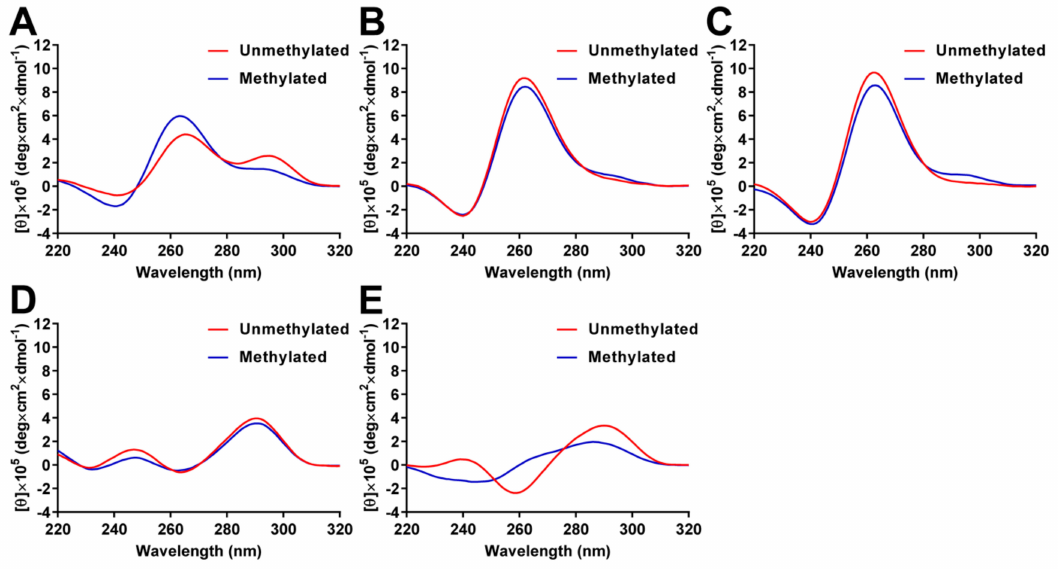
Figure 4. CD spectra of unmethylated and methylated BCL-2 ( A ); VEGF ( B ); HRAS2 ( C ); c-KIT ( D ); and